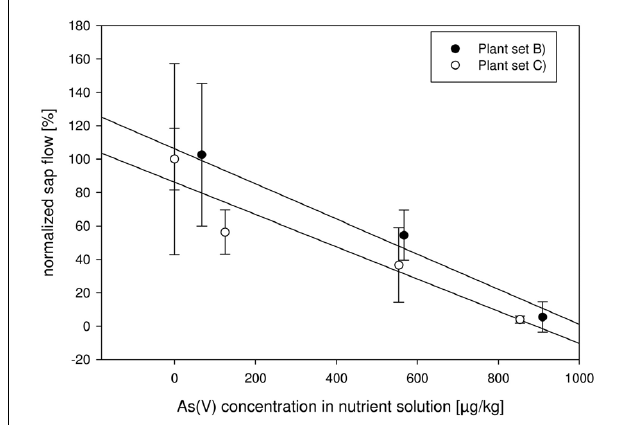
FIGURE 4 | Xylem sap flow normalized against sap of control plants flow vs arsenate concentration in nutrient solution before challenge. Sap flow of control plants set to